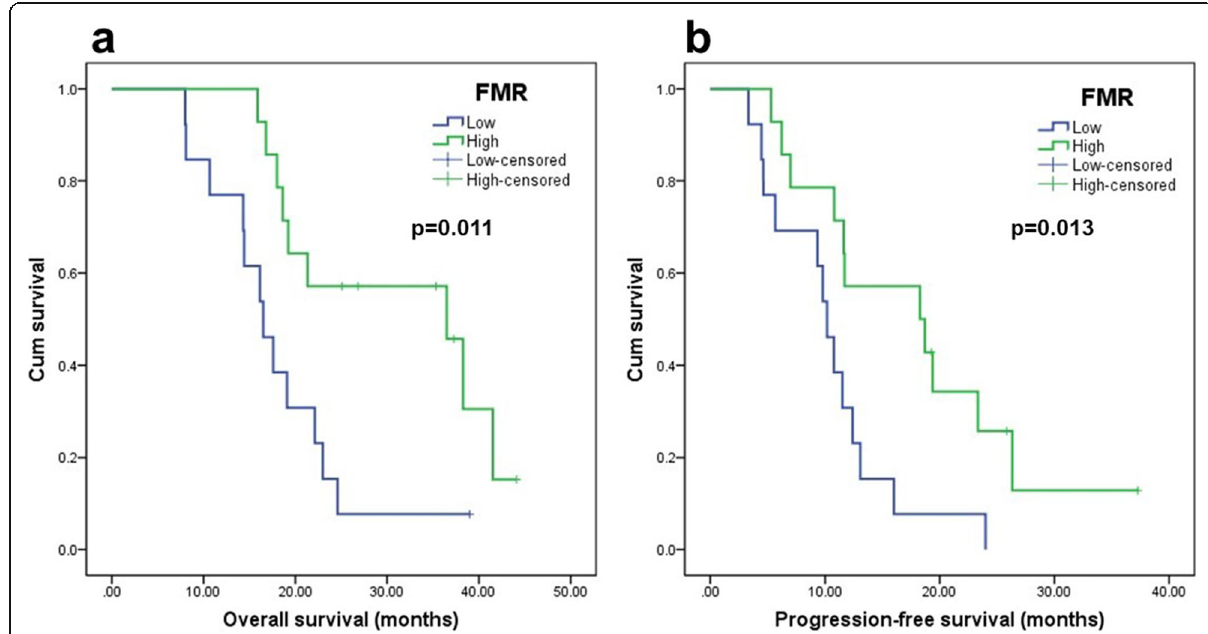
Fig. 3 Kaplan – Meier survival curves showed that patients with low FMR have shorter a overall survival and b progression-free survival than those with high values